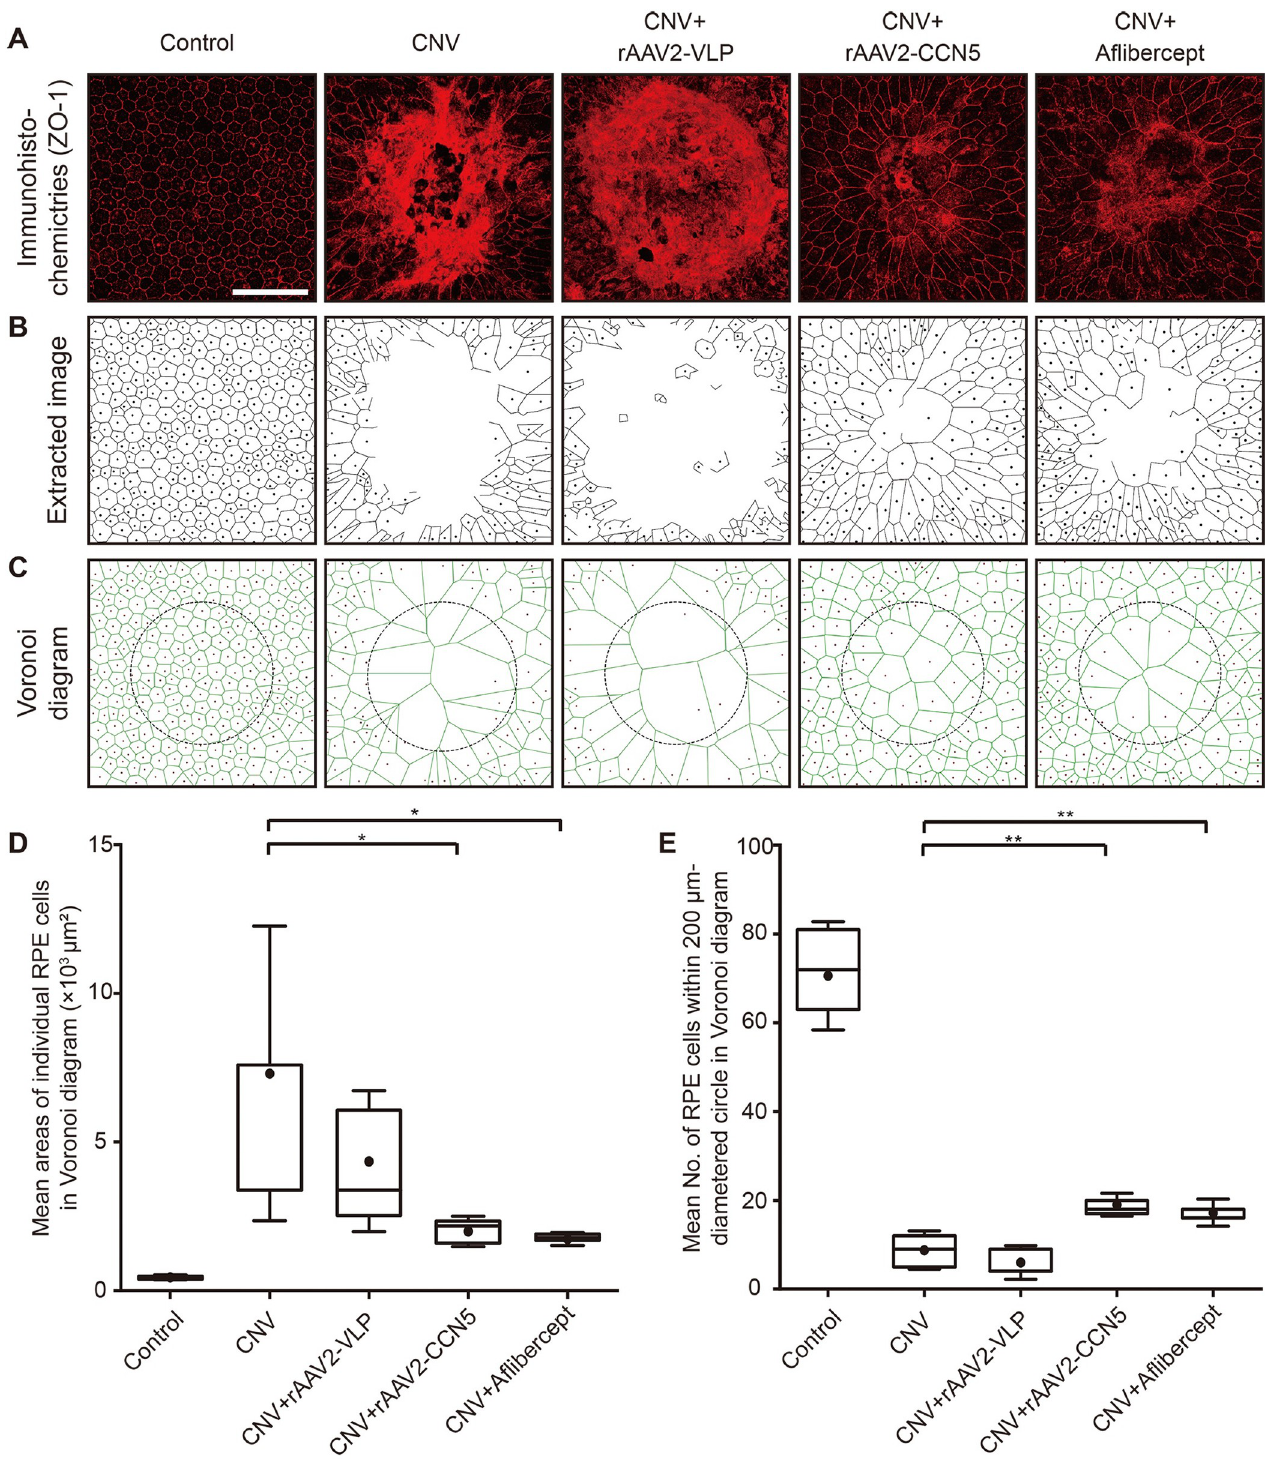
Fig 5. Assessment of RPE cell morphology by a Voronoi diagram. (A). Flat mounts of RPE/choroid complex were immunostained for ZO-1. Representative images are shown. Scale bar, 100 μ m. (B). Extracted images were drawn to demarcate cell boundaries. (C). Voronoi diagrams were virtually generated from the extracted images using computer algorithm. (D). The mean sizes and (E) the mean numbers of RPE cells within the circles of 200 μ m in diameter are calculated and plotted. Bars show the mean ± SD. (n = 5 spots per group; one-way ANOVA or unpaired Student’s two-tailed t-test; � p < 0.05, �� p < 0.01).